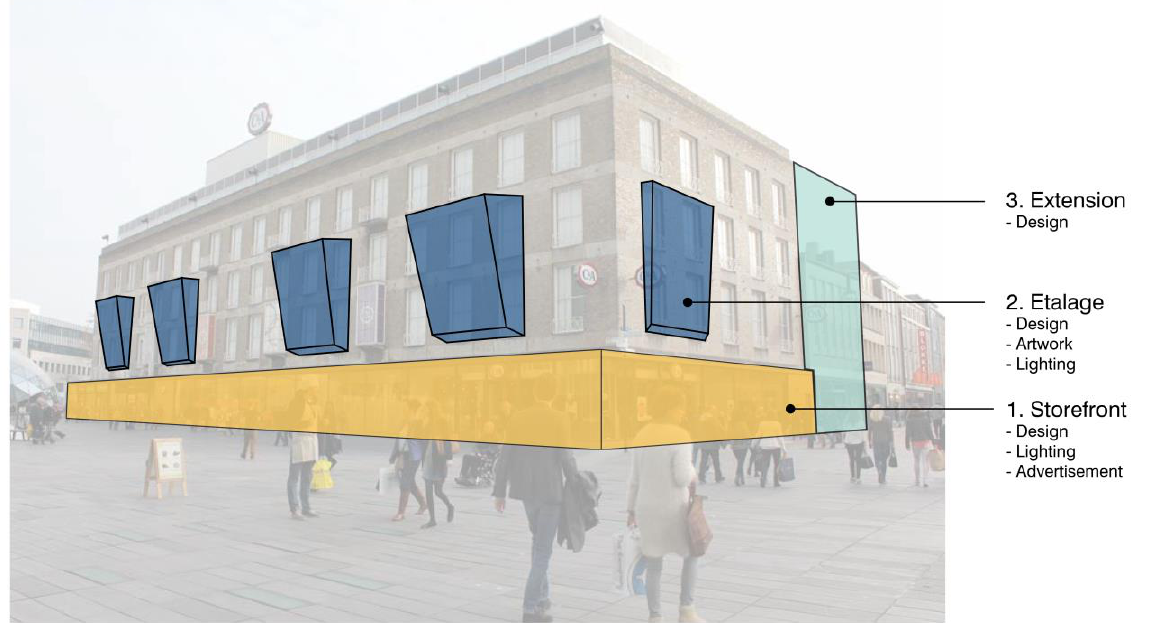
Fig. 1 3D impression of the modernized C&A building by UNStudio (3D impression by